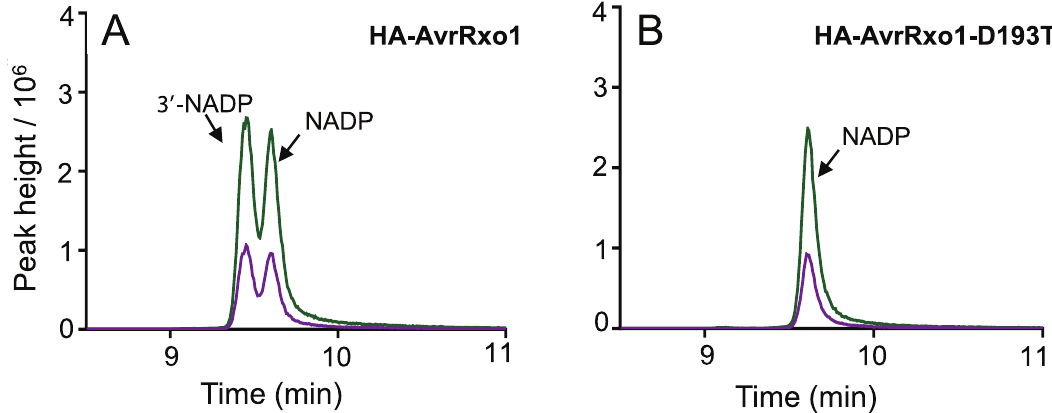
Fig 3. AvrRxo1produces 3’-NADP upon transient expression in N . benthamiana . (A-B) LC-MS/MS analysisof NADP from leaves of N . benthamiana transiently expressingHA-AvrRxo1(A) or HA-AvrRxo1-D193T (B). N . benthamiana leaf samples were collected36 hours post infiltration(hpi), prior to visiblecell collapsesymptoms. Similar results obtainedfor 3